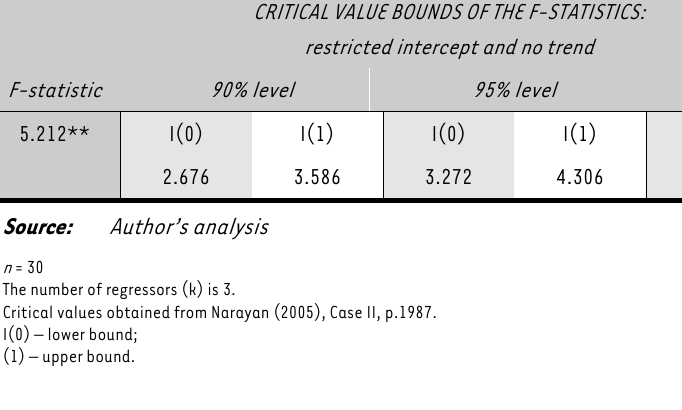
TABLE 3: Cointegration test results CRITICAL VALUE BOUNDS OF THE